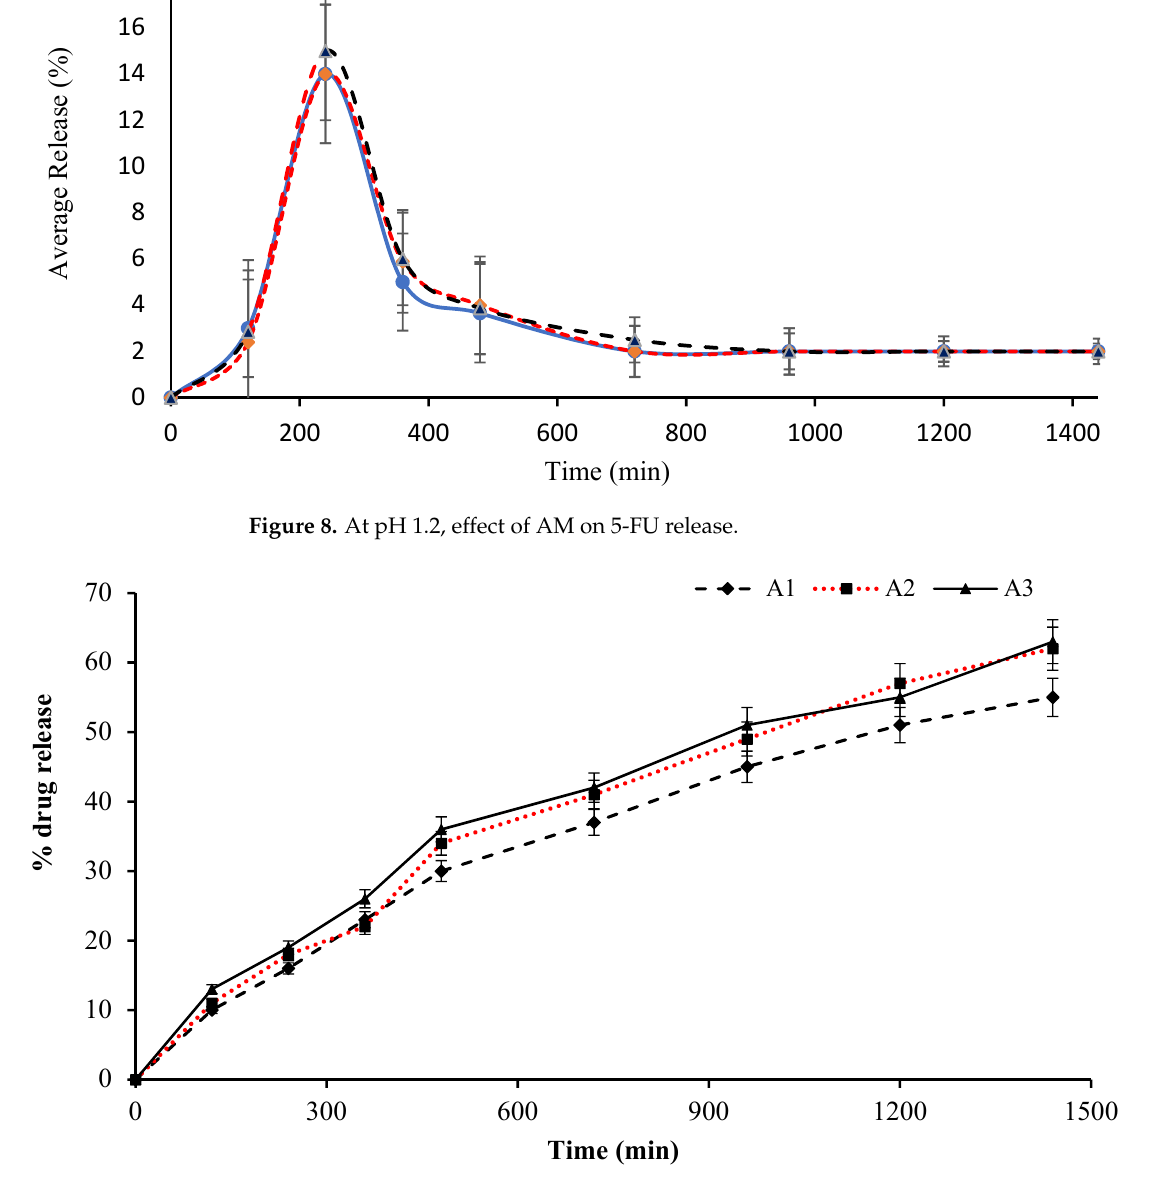
Figure 9. At pH 7.4, effect of AM on 5 FU release profile.